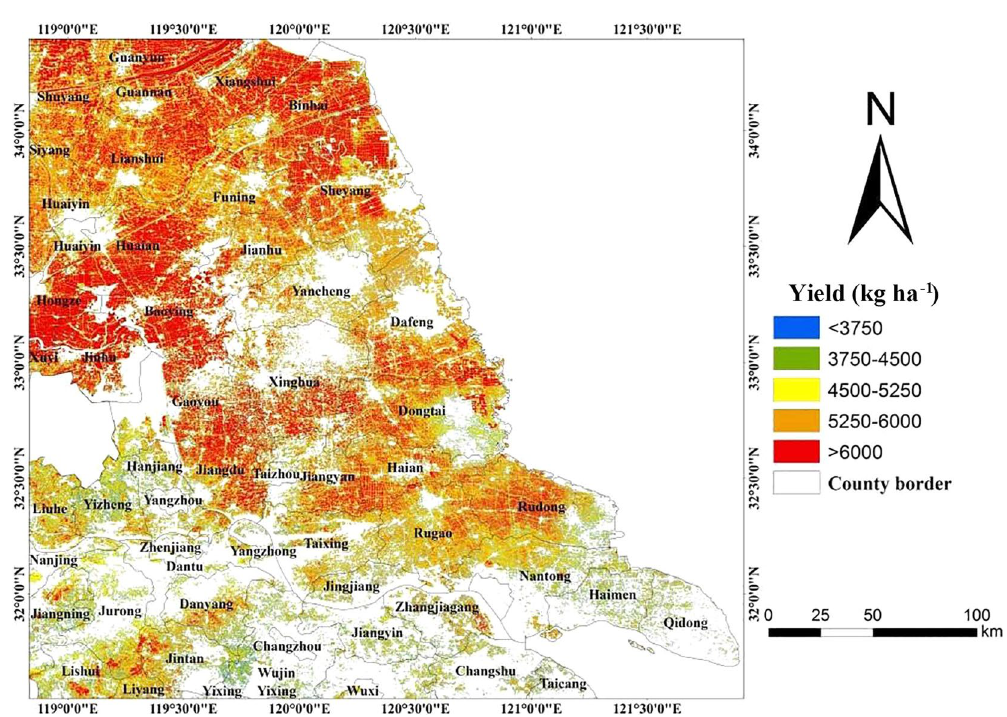
Figure 3. Spatial distribution of winter wheat yield in central Jiangsu region,